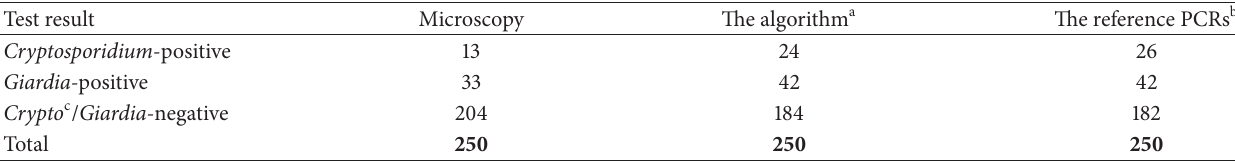
Table 4: Diagnostic tests’ results on 250 random stool